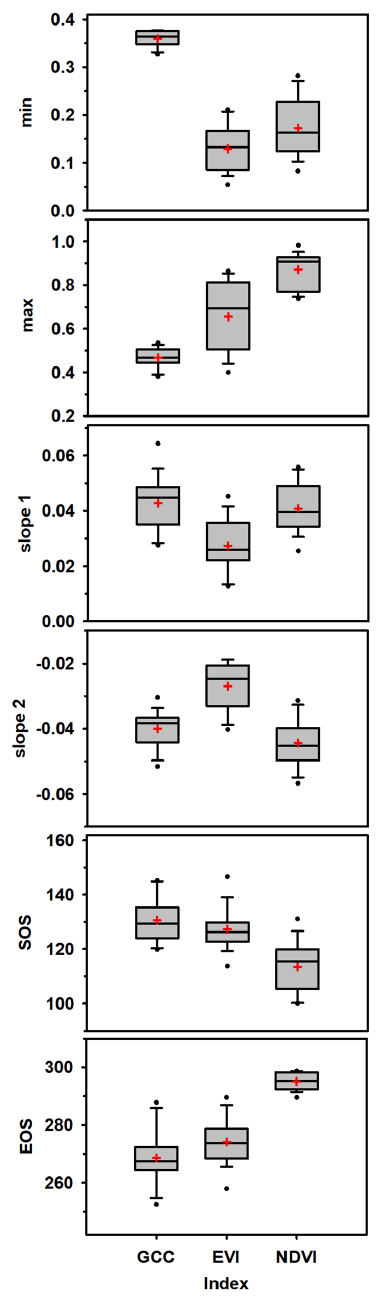
Figure 5. Mixed-model-based comparison of GCC, NDVI, and EVI derived phenology parameters, Mixed-model-based comparison of GCC, NDVI, and EVI derived Phenological parameters of black spruce computed using Equation (4) for six PhenoCam sites along the latitude in Quebec, Canada. Boxes represent upper and lower quartiles, whiskers achieve the 10th and 90th percentiles, and the mean and median are drawn as red cross and horizontal black solid lines,